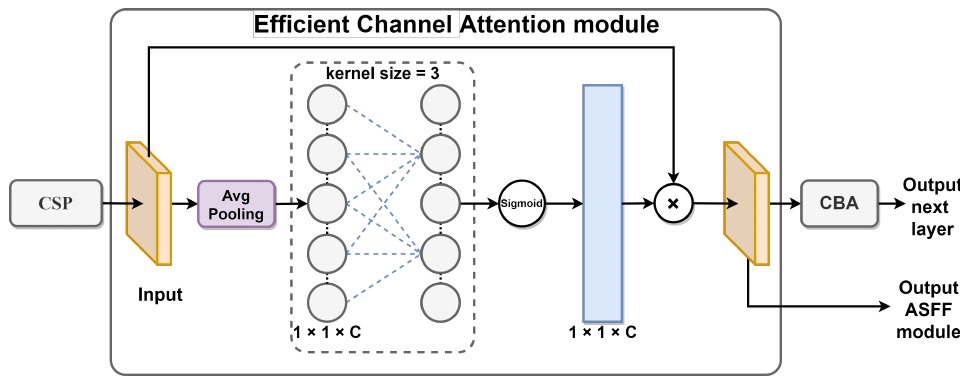
Figure 3. An overview of the ECA